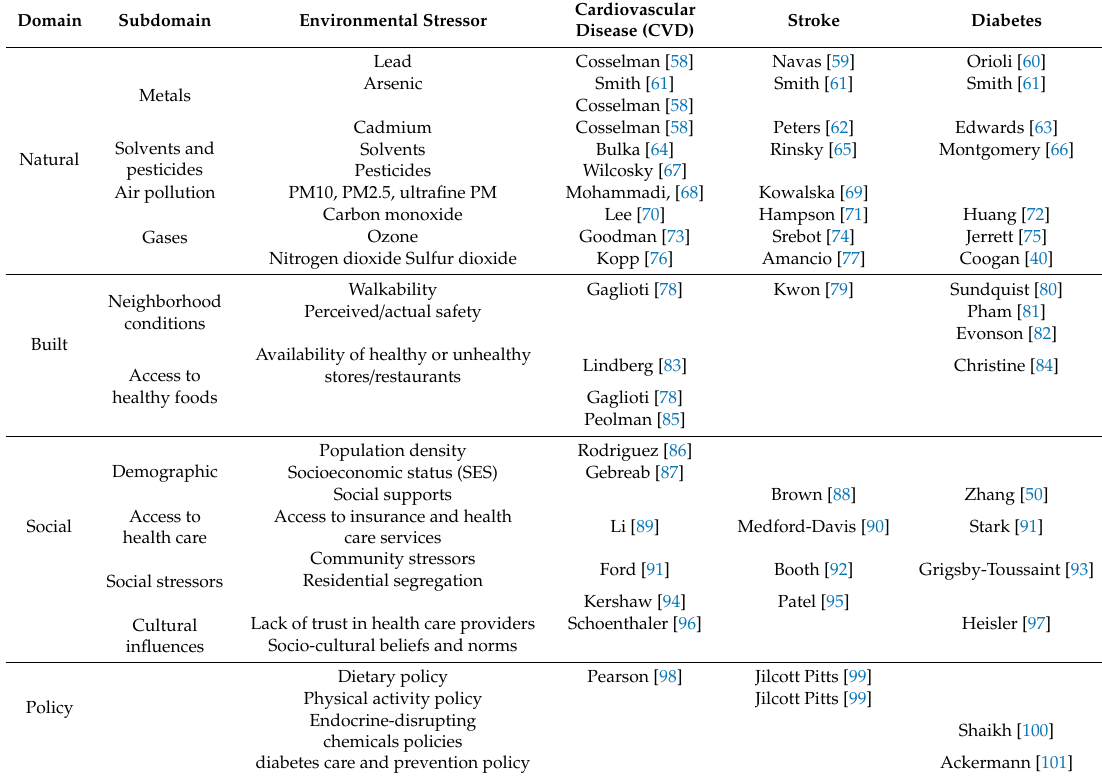
Table 1. Environmental risk factors for cardio-metabolic